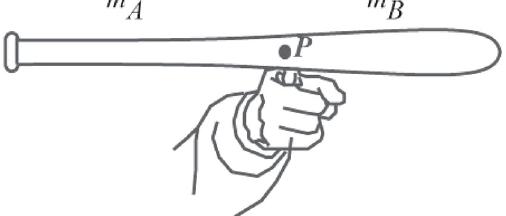
FIG. 1. Figure used in the bat version of the mass comparison task. Students were told that the bat is balanced on the finger. They are asked (1) if the center of mass of the bat is to the left of, to the right of, or at point P and (2) if the mass of the piece to the left of point P is greater than, less than or equal to the mass to the right of point P . The bat is stylized in order to make it easier for students to gauge the location of the c.m. of each piece by